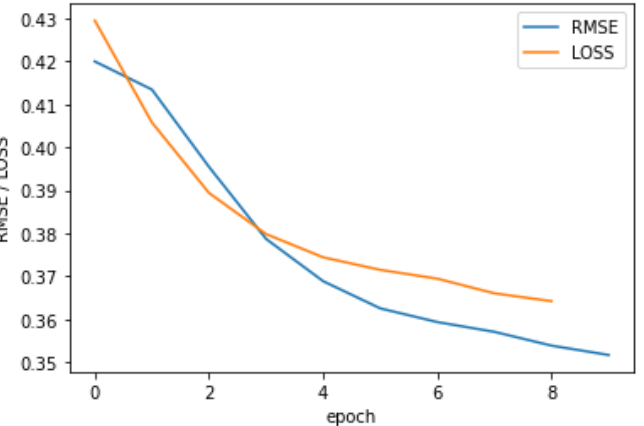
Figure 36. Performance evaluation of recommendation system based on RMSE and LOSS.